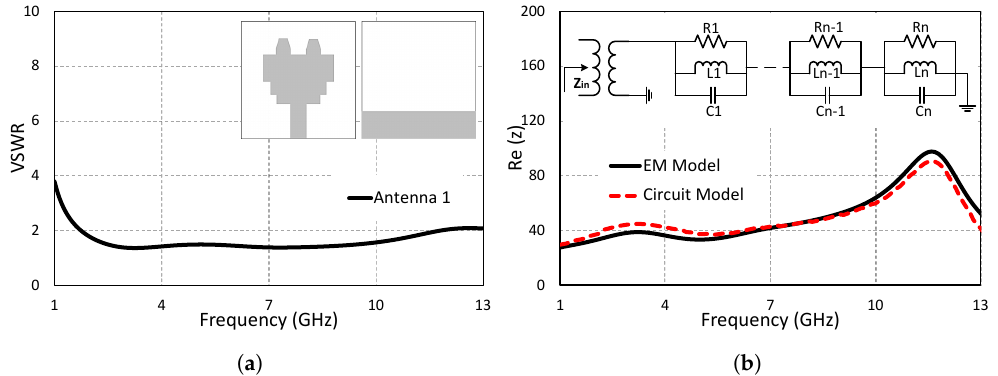
Figure 2. Step 1: Ultra-wideband (UWB) antenna, ( a ) voltage standing wave ratio (VSWR). ( b ) Input impedance